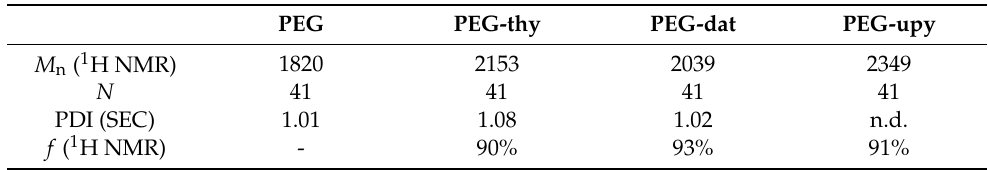
Table 1. Characteristics of the supramolecular polymer blocks and the reference PEG polymer block: M n is the molar mass of one unit * (g · mol − 1 ), N is the number of repeating monomer units in the corresponding PEG polymer block, PDI is the polydispersity index and f is the functionalization degree of the supramolecular polymer blocks. PEG PEG-thy PEG-dat PEG-upy M n ( 1 H NMR) 1820 2153 2039